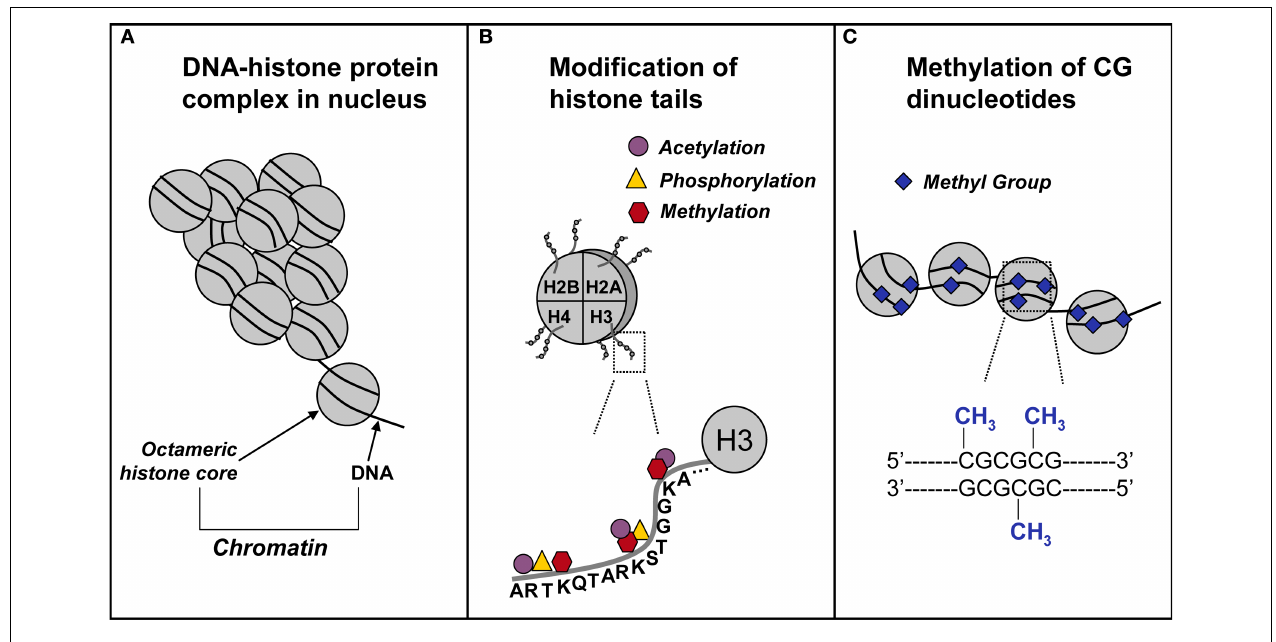
FIGURE 1 | Schematic representation of epigenetic mechanisms. (A) In the nucleus, DNA coils and condenses around histones. Each octameric histone core contains two copies each of histones H2A, H2B, H3, and H4. The DNA–protein complex is referred to as chromatin. (B) The DNA-histone interaction occurs at the N-terminal tail of a histone, where for example on the